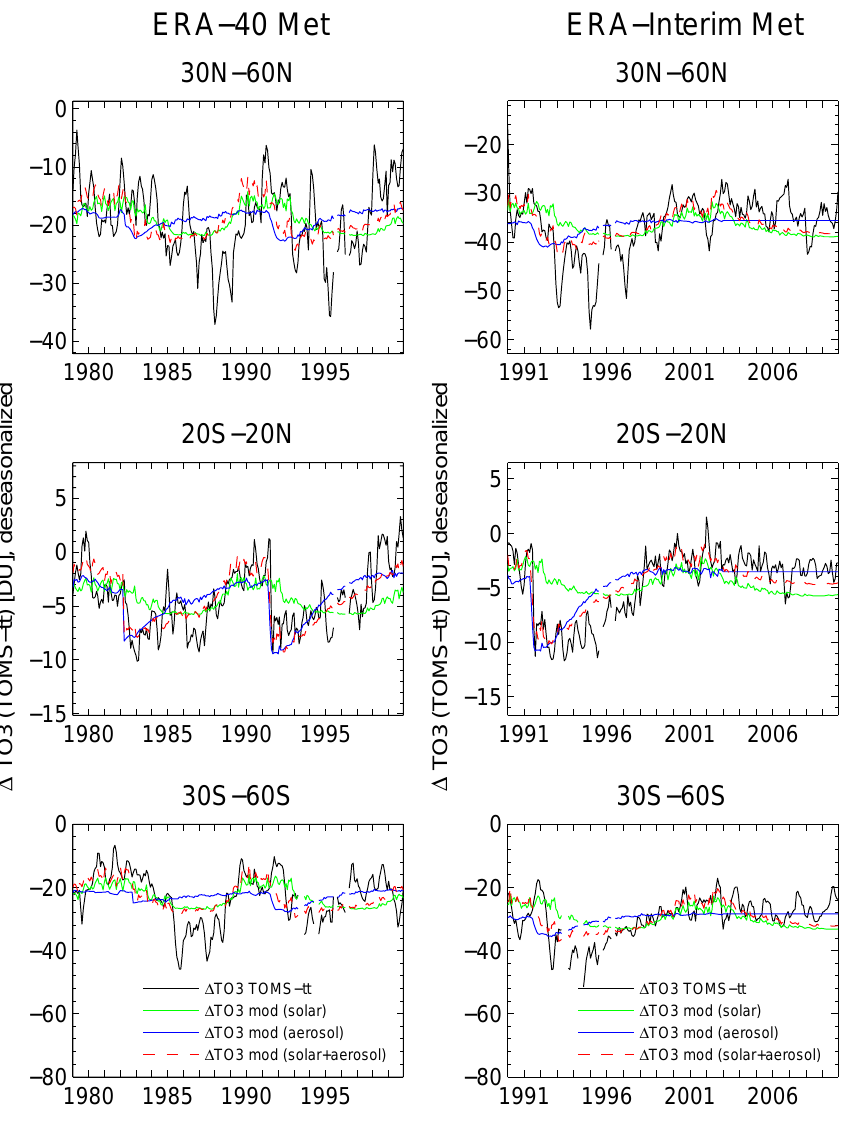
Fig. 6. Regression analysis of TO3 deviation (TOMS/SBUV observations – CTM run tt ) to solar F 10 . 7 radio flux and SAGE aerosol optical depth. Left: ERA-40 driven model run (1979–1999), right: ERA-Interim driven model run (1990–2009). The actual deseasonalized TO3 offset between observations and model (black line) is shown along with the best fit including the solar proxy only (green line), the aerosol proxy only (blue line), and both (red dashed